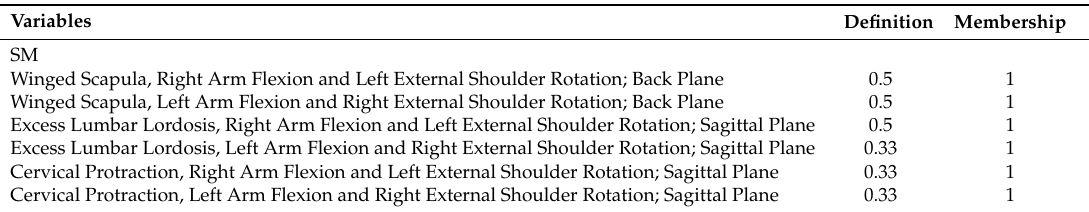
Table 6. Assessment of Aiken V by ten experts of the proposed variables for SM.